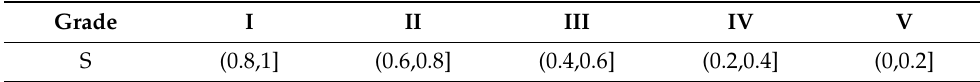
Table 7. Reference table for grading target level assessment